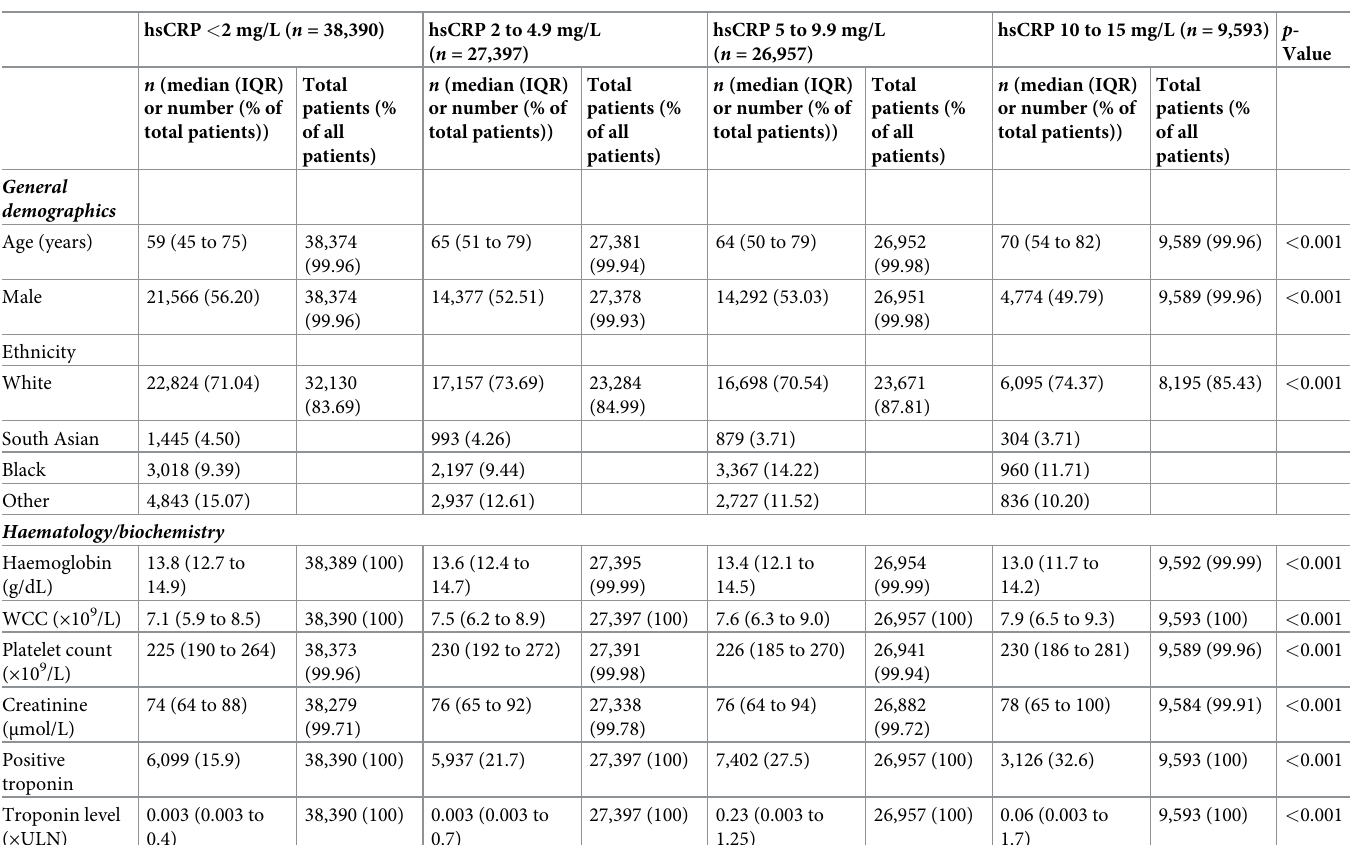
Table 1. Baseline clinical characteristics.